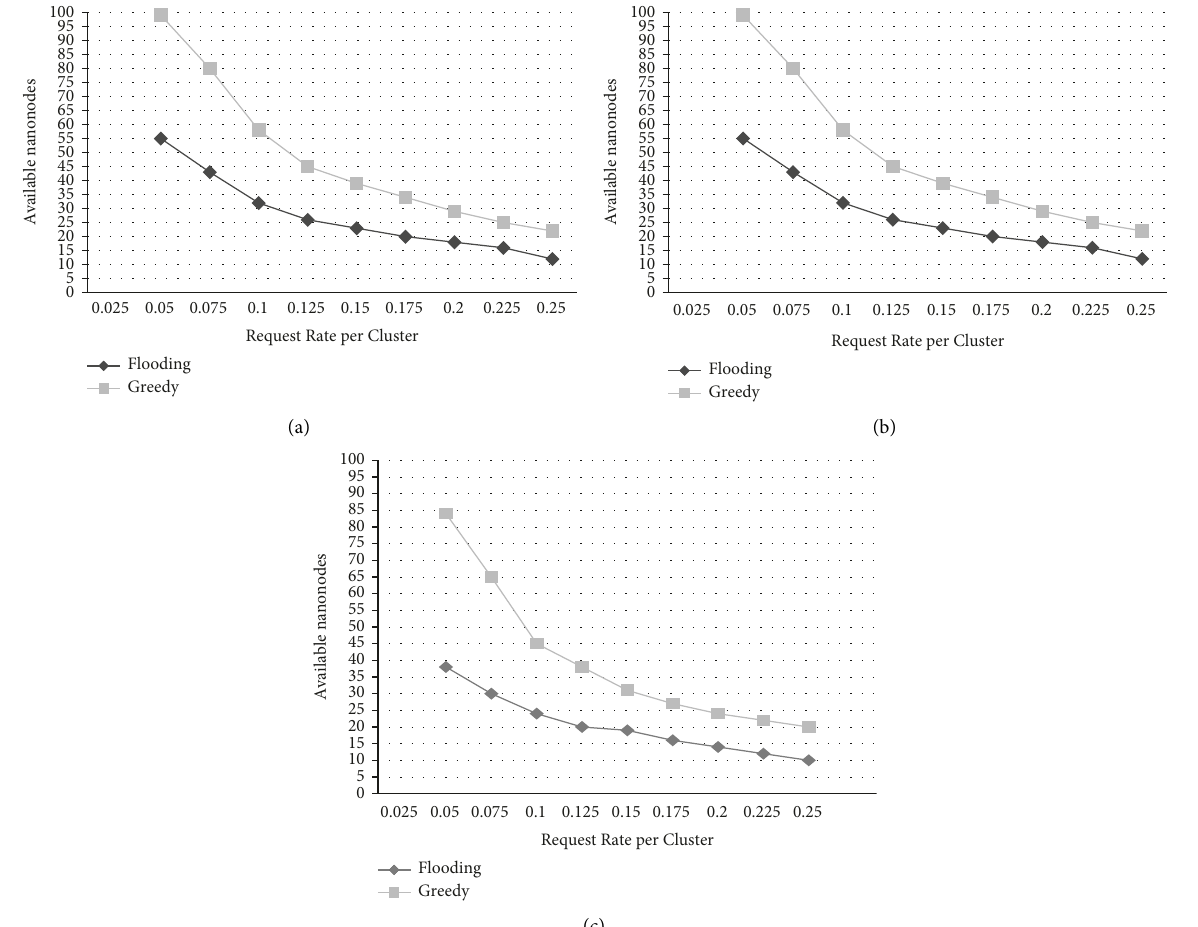
Figure 21: (a) Available nanonodes in each nanocluster when an average number of nanonodes per nanoclusters are 50. (b) Available nanonodes in each nanocluster when an average number of nanonodes per nanoclusters are 100. (c) Available nanonodes in each nanocluster when an average number of nanonodes per nanoclusters are 150.